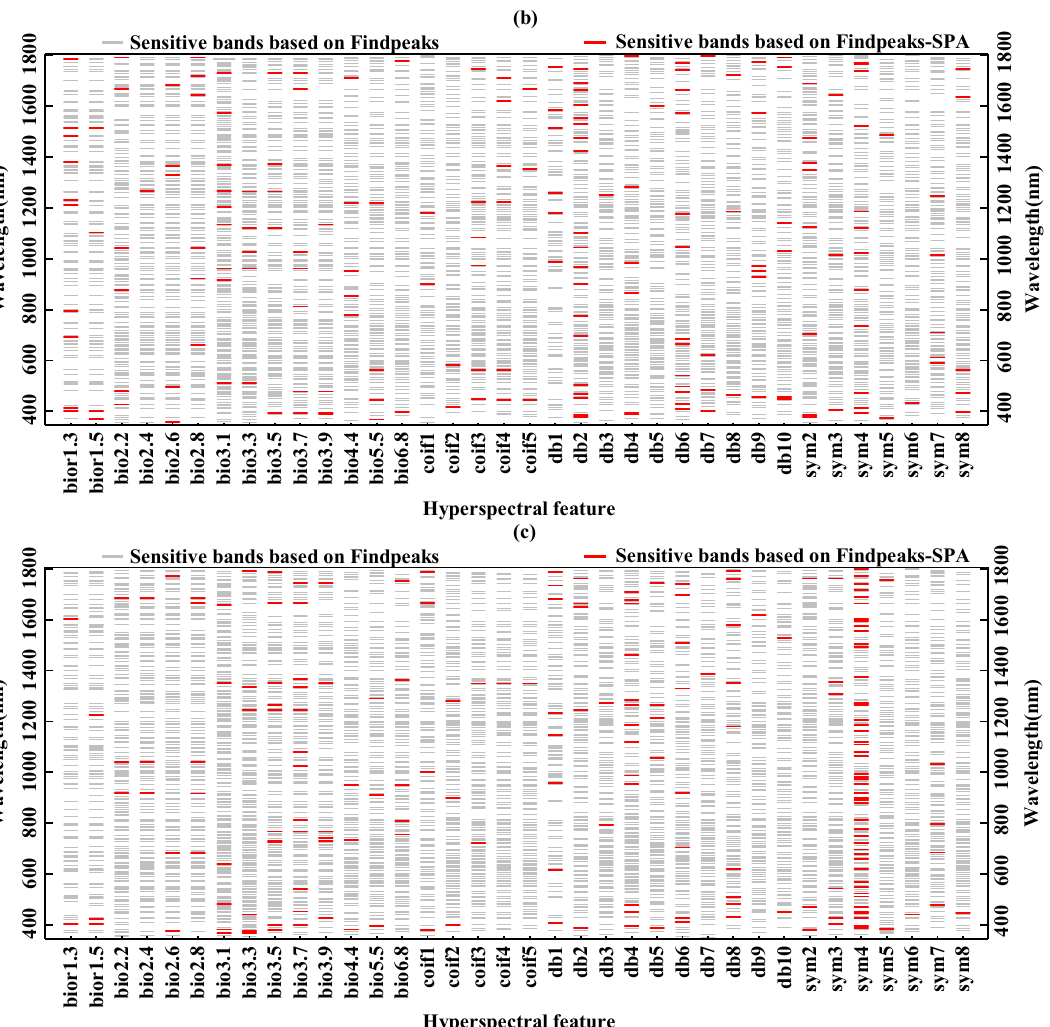
Figure 5. Sensitive spectral features: ( a ) chlorophyll content; ( b ) fresh weight moisture content; ( c ) dry weight moisture content.